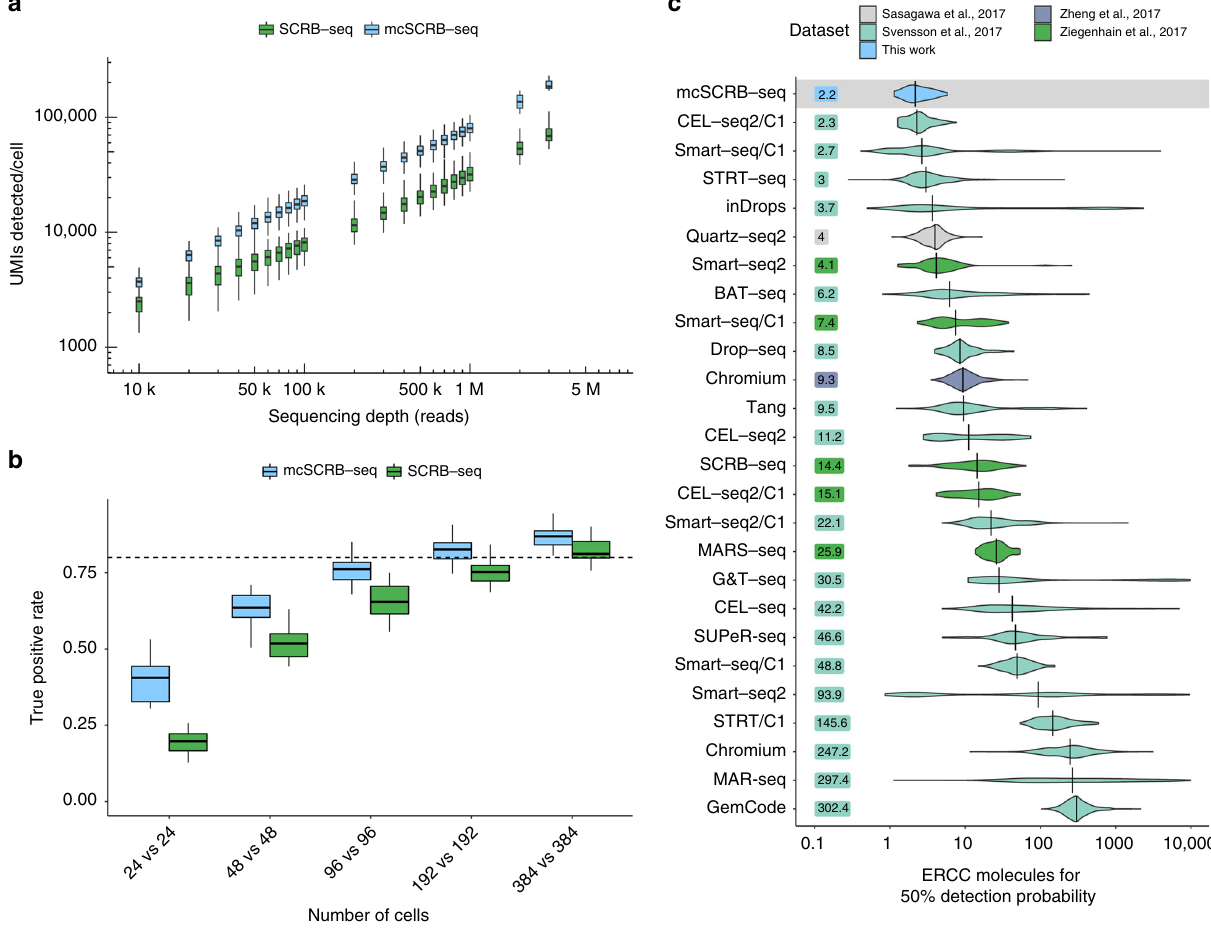
Fig. 2 Comparison of mcSCRB-seq to SCRB-seq and other protocols. a Number of UMIs detected in libraries generated from 249 single mESCs using SCRB-seq or mcSCRB-seq when downsampled to different numbers of raw sequence reads. Each box represents the median and fi rst and third quartiles per cell, sequencing depth and method. Whiskers indicate the most extreme data point that is no more than 1.5 times the length of the box away from the box. b The true positive rate of mcSCRB-seq and SCRB-seq estimated by power simulations using the powsimR package 22 . The empirical mean – variance distribution of the 10,904 genes that were detected in at least 10 cells in either mcSCRB-seq or SCRB-seq (500,000 reads) was used to simulate read counts when 10% of the genes are differentially expressed. Boxplots represent the median and fi rst and third quartiles of 25 simulations with whiskers indicating the most extreme data point hat is no more than 1.5 times the length of the box away from the box. The dashed line indicates a true positive rate of 0.8. The matching plot for the false discovery rate is shown in Supplementary Fig. 11d. c Sensitivity of mcSCRB-seq and other protocols, calculated as the number of ERCC molecules needed to reach a 50% detection probability as calculated in Svensson et al 5 . Per-cell distributions are shown using violin plots with vertical lines and numbers indicating the median per